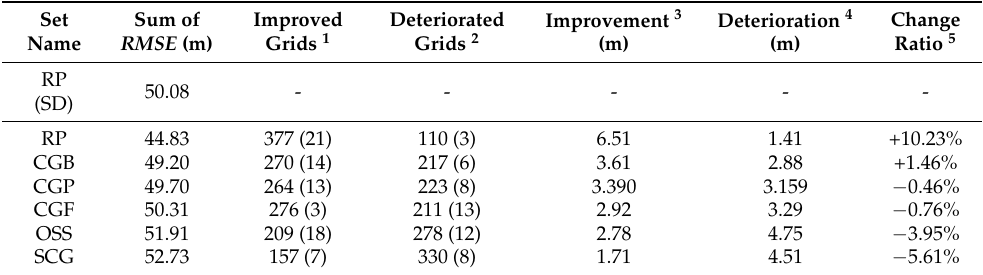
Table 1. Statistics of the RMSE difference map for ANN on the testing dataset. Only the benchmark ANN, RP (SD), was trained with the synthetic database. All other ANN were trained with the hybrid database.